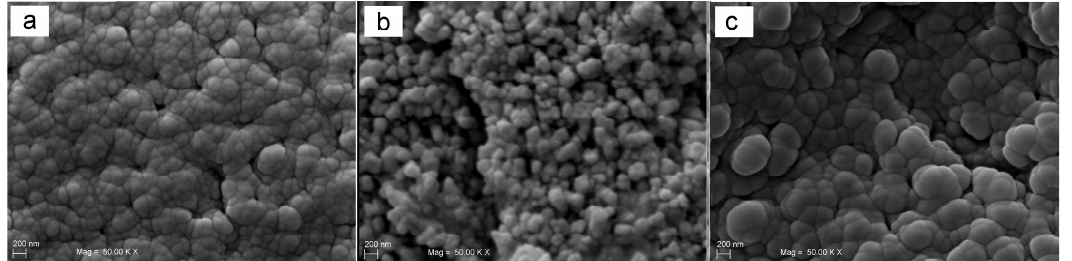
Figure 2. SEM images showing the micrograins of Y-TZP Groups (50000× magnification). ( a ) High- translucent zirconia; ( b ) low-translucent zirconia; ( c ) high-translucent zirconia after aging.